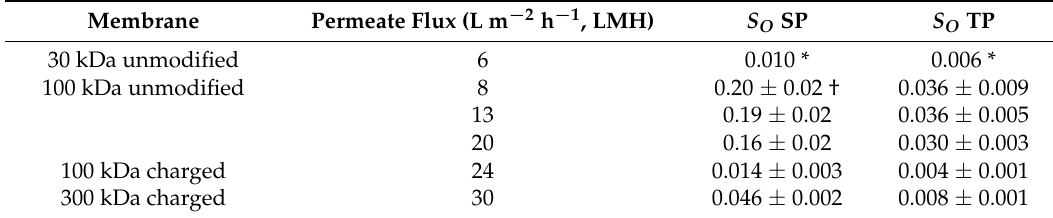
Table 1. Sieving coefficients ( S O ) for serum protein (SP) and true protein (TP) measured at total recycle during the ultrafiltration of skim milk at 22 ◦ C using different membranes.